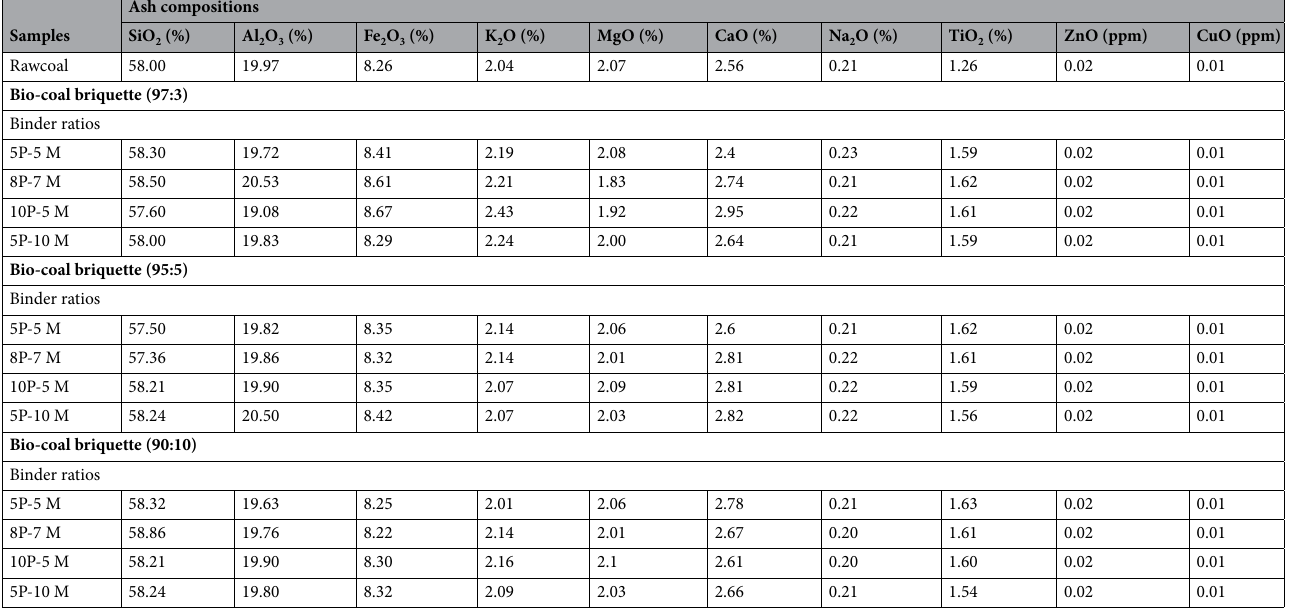
Table 2. Ash composition of the raw coal and bio-coal briquettes.